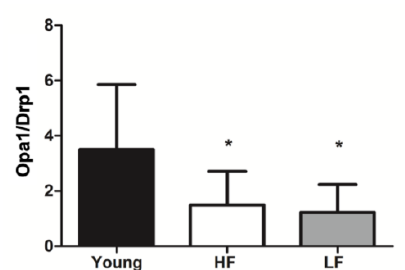
Figure 3. Mitochondrial fusion index in the vastus lateralis muscle of young and old participants. The fusion index was calculated as the ratio between protein levels of the fusion marker optic atrophy 1 (Opa1) and those of the fission factor dynamin-related protein 1 (Drp1). Differences among groups were assessed by one-way ANOVA. Bars represent mean values ( ± standard deviation) for the three experimental groups. * p < 0.05 vs. young group ( n = 11); HF: high-functioning ( n = 16); LF: low-functioning ( n = 7).